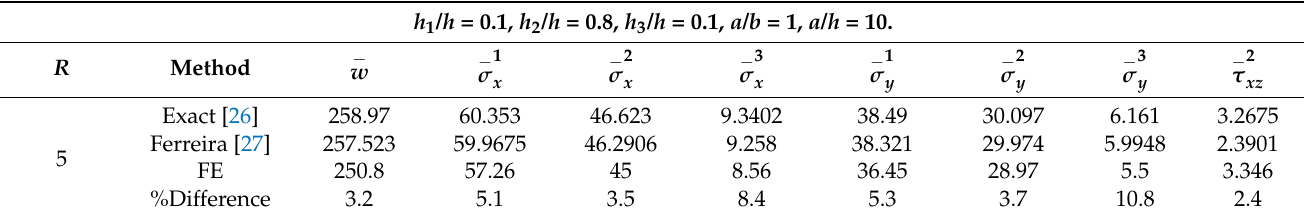
Table 1. Comparison of the results based on FE and those of analytical solution from Refs.